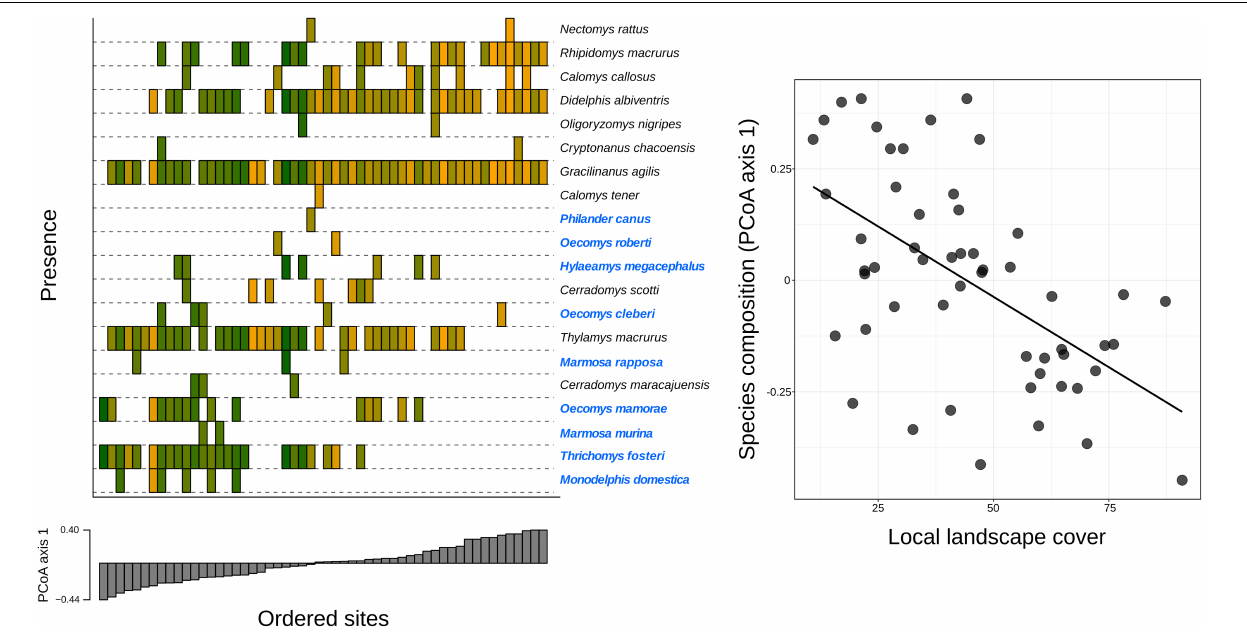
FIGURE 4 | Relationship of species composition and local landscape cover in a woodland savanna region of South America. Ordination histograms show species presence and composition among the sampled sites. Sites are ordered according to the first axis of a Principal Coordinates Analysis (PCoA axis 1) based on the Jaccard dissimilarity index. Adjacent columns (in gray; PCoA loadings) indicate sites with a more similar species composition. Colors represent the amount of local landscape cover, which ranged from least (orange) to most coverage in the local landscape (green). Note that sites located on the negative portion of axis 1 are more often associated with local landscapes that have greater vegetation cover and habitat-specialist species (species names colored in blue, according to Melo et al., 2017).